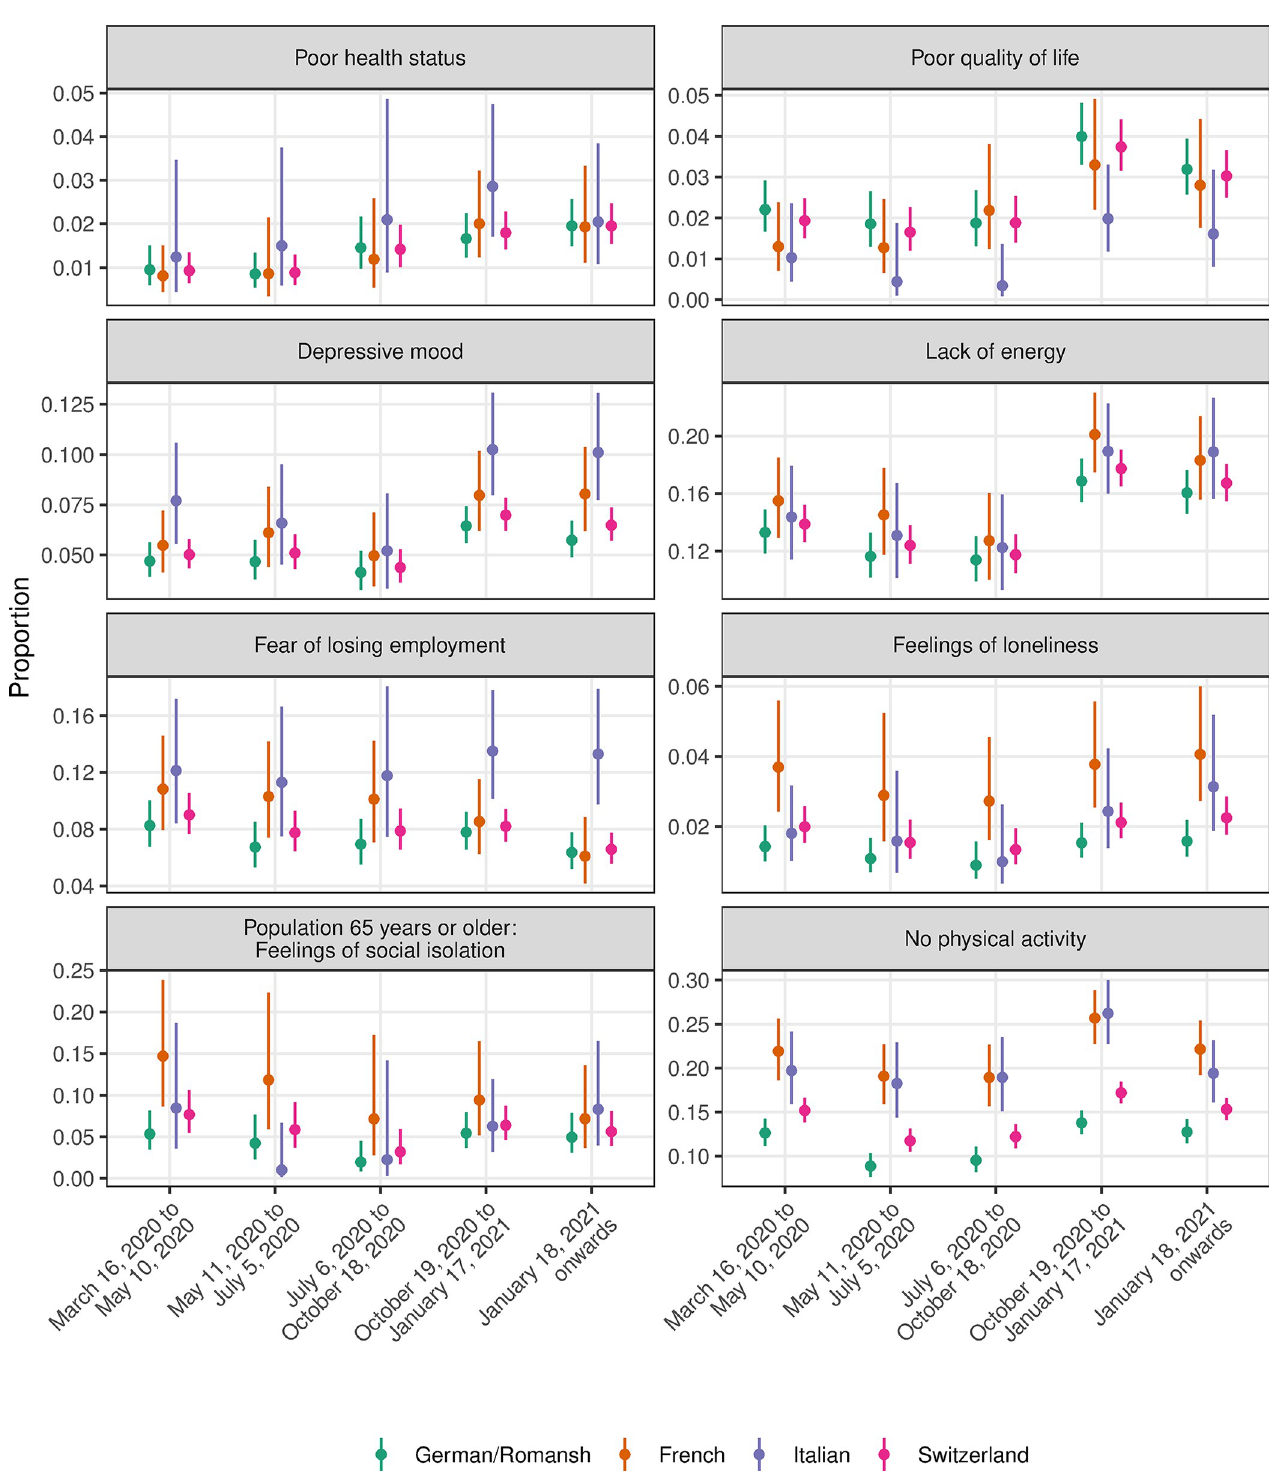
Fig 3. Proportion of study outcomes for the domains of health, loneliness/isolation and physical activity, by mitigation period, language region and for the whole of Switzerland.